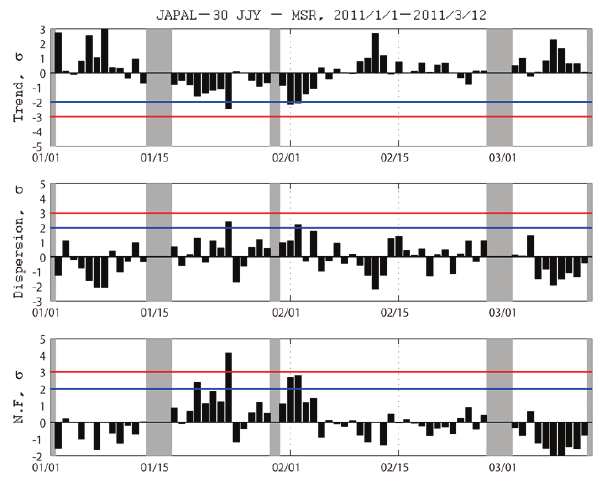
Figure 2. The temporal evolution of the propagation characteristics for the path of JJY–MSR during the period from January 1 to March 12, 2011. Pay attention only to the period from March 1 to March 12 to define any precursor to the March 11, 2011, earthquake. Top: trend (average night-time amplitude). Middle: dispersion (as a measure of the amplitude fluctuation). Bottom: night-time fluctuation, as defined by the night-time integration of the area of dA(t)<0. The gray areas indicate periods with no observations.